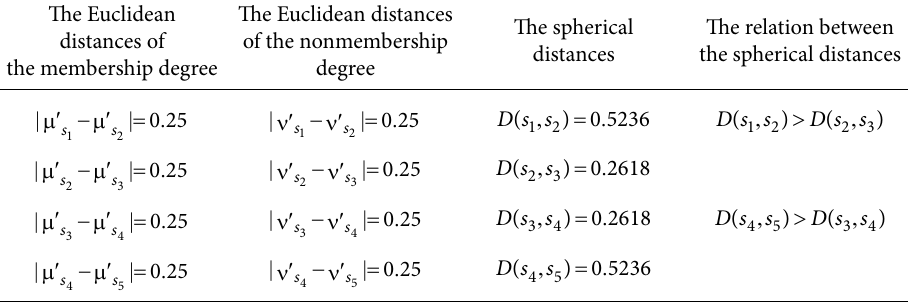
Table 1. The spherical distances between the linguistic term of IFSs The Euclidean The Euclidean distances distances of of the the membership degree